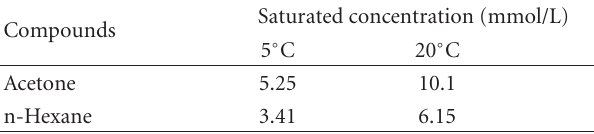
Table 2: Saturated gas concentration of acetone and